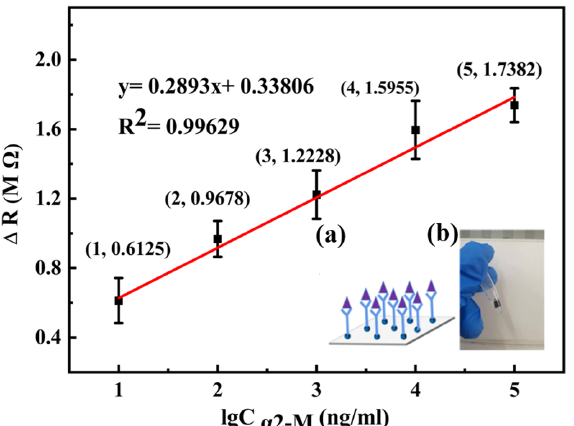
Figure 9. ∆ R of the biosensor detecting α 2-M in the range of 10 ng · mL − 1 –100 µ g · mL − 1 and linear fitting curve. Illustration ( a ) is a schematic diagram of the process of the antigen binding with the antibody and illustration ( b ) is a picture of the experiment process.